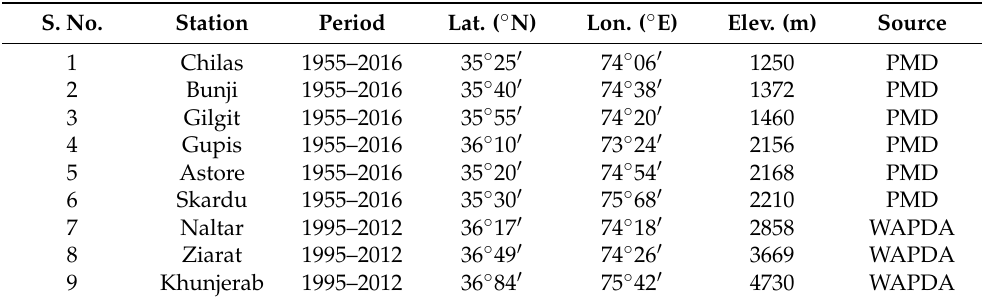
Table 1. Description of meteorological stations in the Upper Indus Basin used in